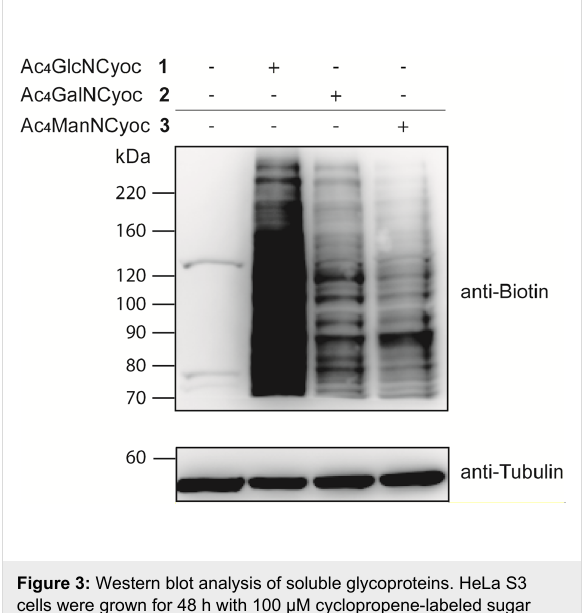
Figure 3: Western blot analysis of soluble glycoproteins. HeLa S3 cells were grown for 48 h with 100 µM cyclopropene-labeled sugar (Ac 4 GlcNCyoc ( 1 ), Ac 4 GalNCyoc ( 2 ), or Ac 4 ManNCyoc ( 3 )) or with PBS (solvent control), lysed, and the cleared lysate was reacted with Tz–biotin 10 (150 µM, 90 min, rt). Proteins were immunoblotted for biotin and tubulin (loading control). Protein bands visible in the